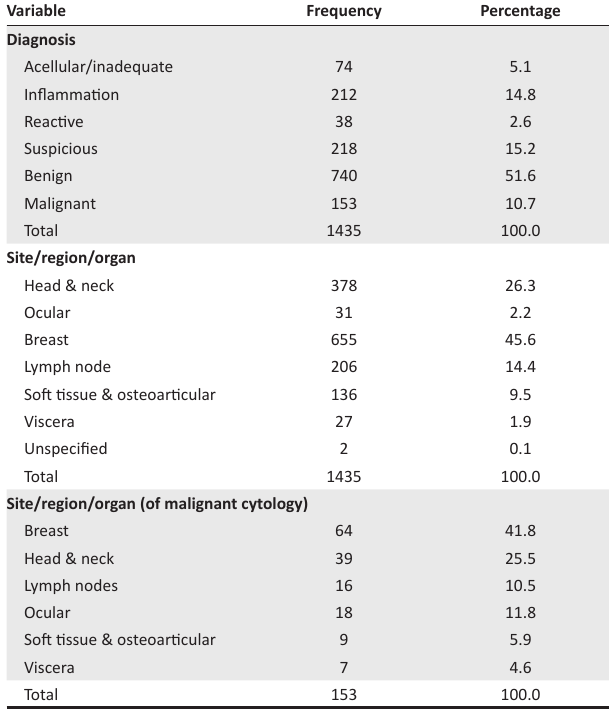
TABLE 2: Distribution of fine needle aspiration biopsy by diagnosis, site and malignant cytologic diagnosis in Sokoto.